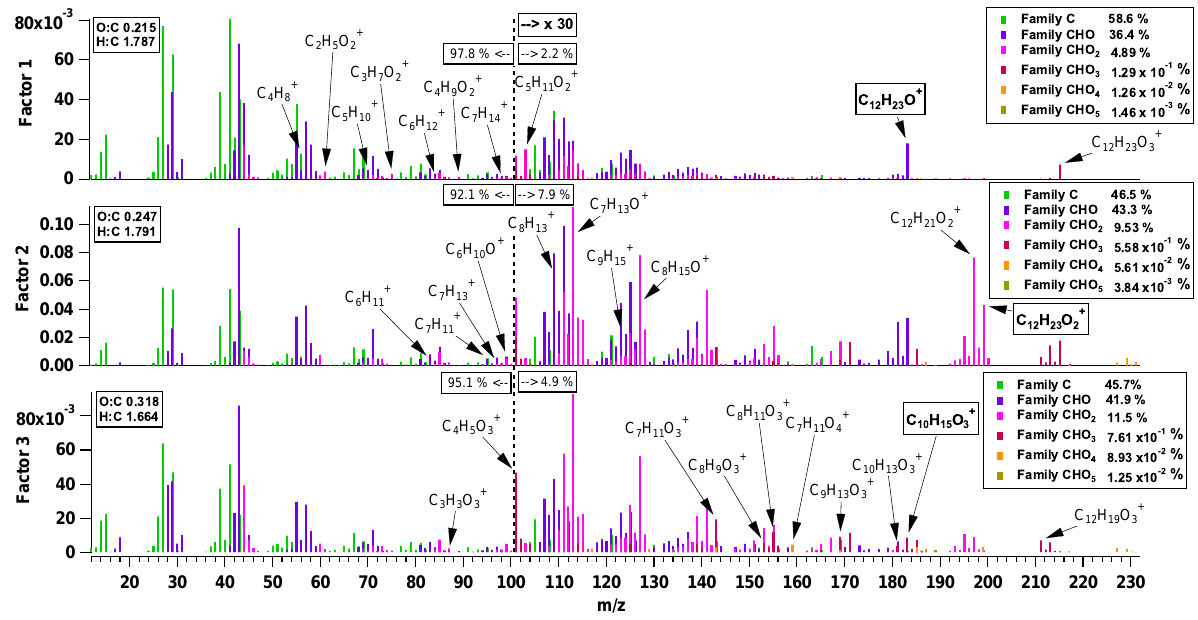
Fig. 7. The 3-factor mass spectra profiles in terms of their families. The ions past m/z 100 are multiplied by 30 to amplify signal strength.